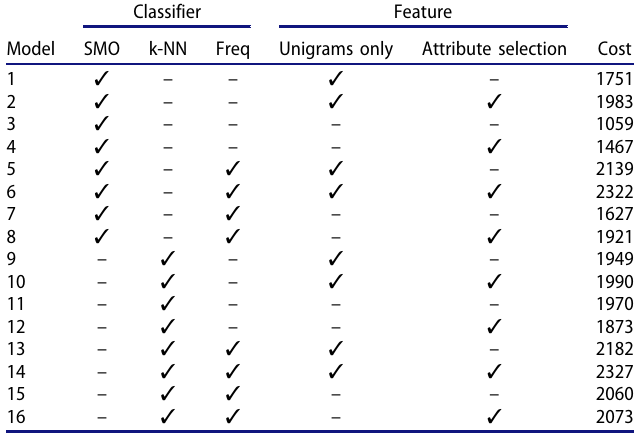
Table 5. Result of the application of the cost matrix to the remaining 16 models. Classifier